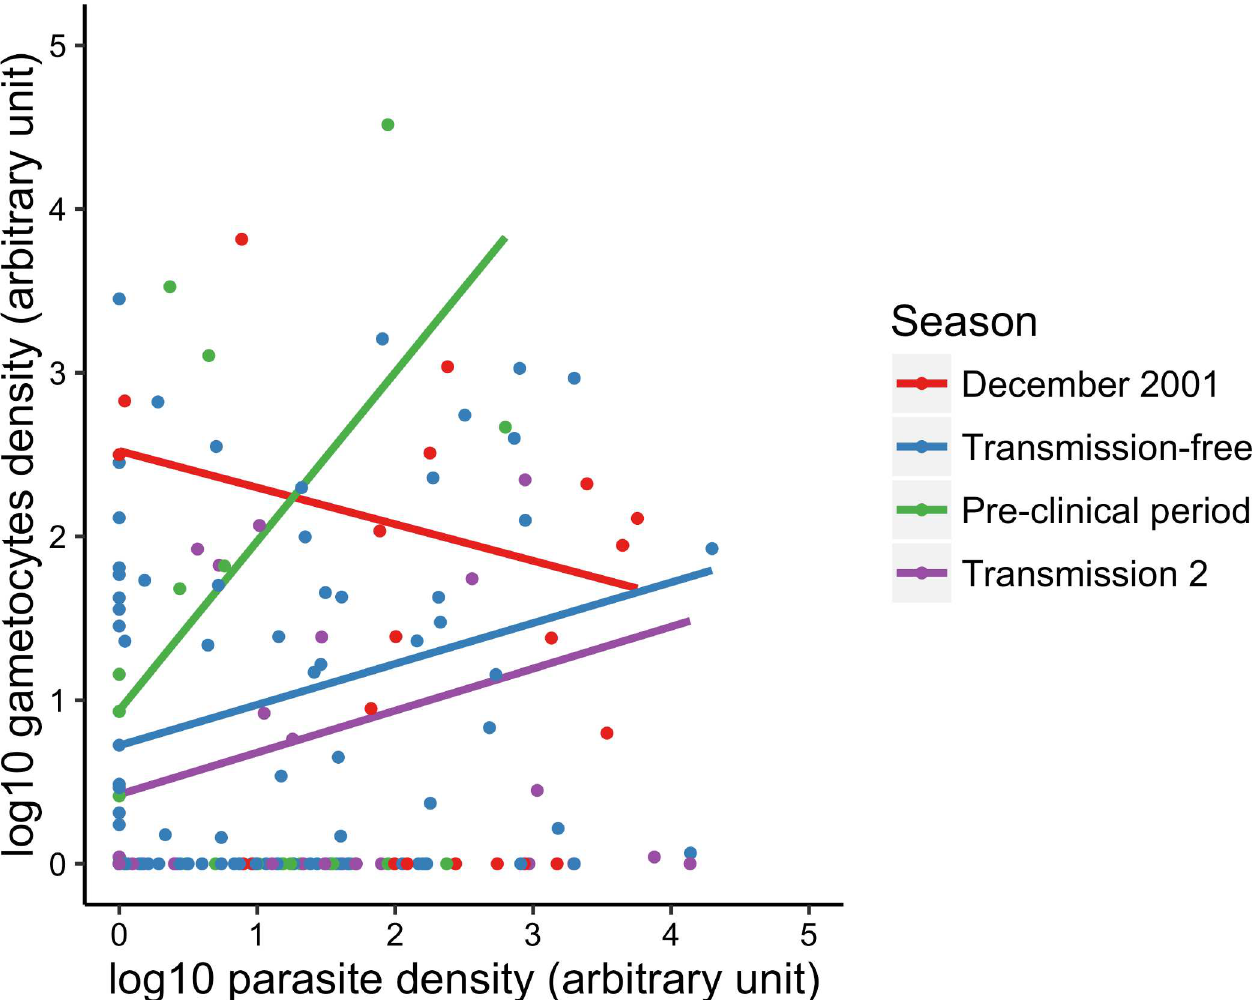
Fig 3. Correlation between parasite and gametocytedensities across seasons. The correlationbetweengametocyte and parasite densities varied across the seasons (i.e. there is a season by parasite density interaction). During the pre-clinical period, a strong and positive correlation was observed.This suggeststhat a larger proportionof total parasitesare gametocytesduringthe pre-clinicalseason, comparedto the other 3 seasons. Points represent raw data; lines represent the best-fit betweenvalues of log 10 parasite and gametocytes densitiesas classified by season. Arbitrary numbers are used to present gametocyte and total parasitedensities,denotedas blood RNA and blood DNA , to account for sample processingdifferencesthat might result in the appearance that some samples containmore gametocytes than total